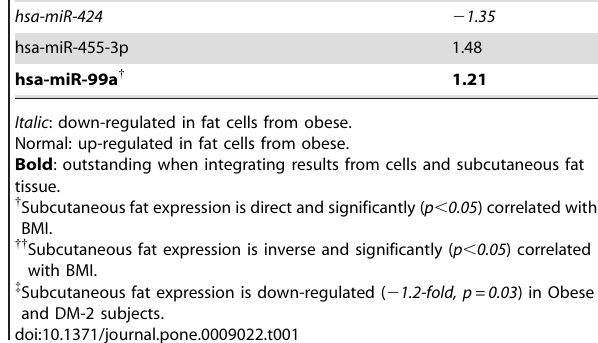
Pre-adipocytes (Obese vs.